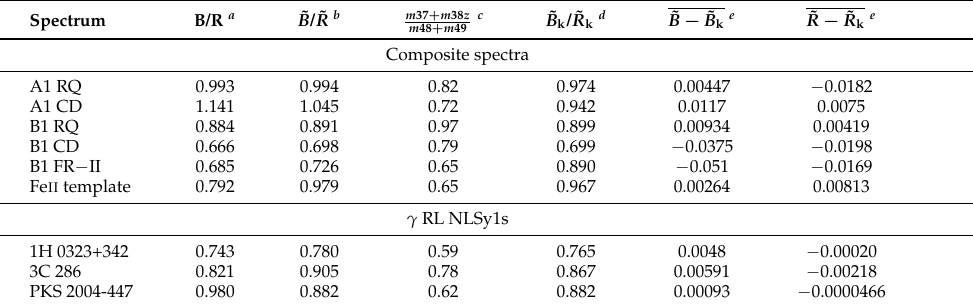
Table 3. “Liquid” Fe II